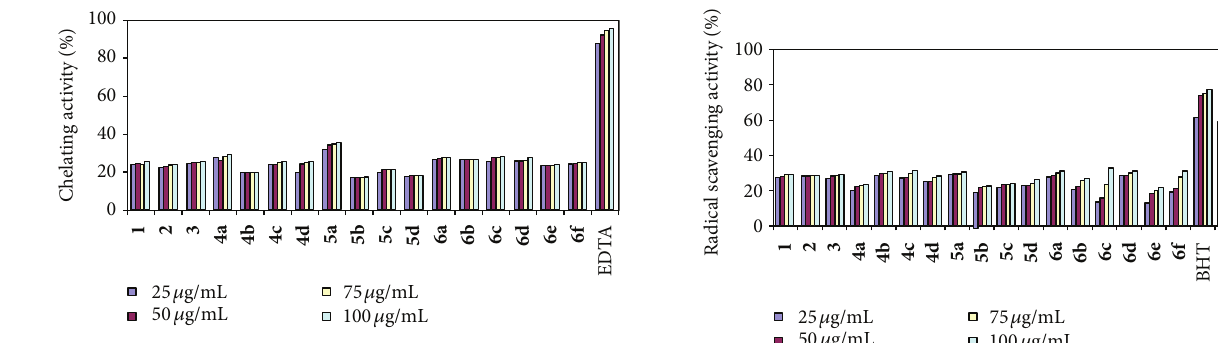
Table 1: Radical scavenging activity (IC